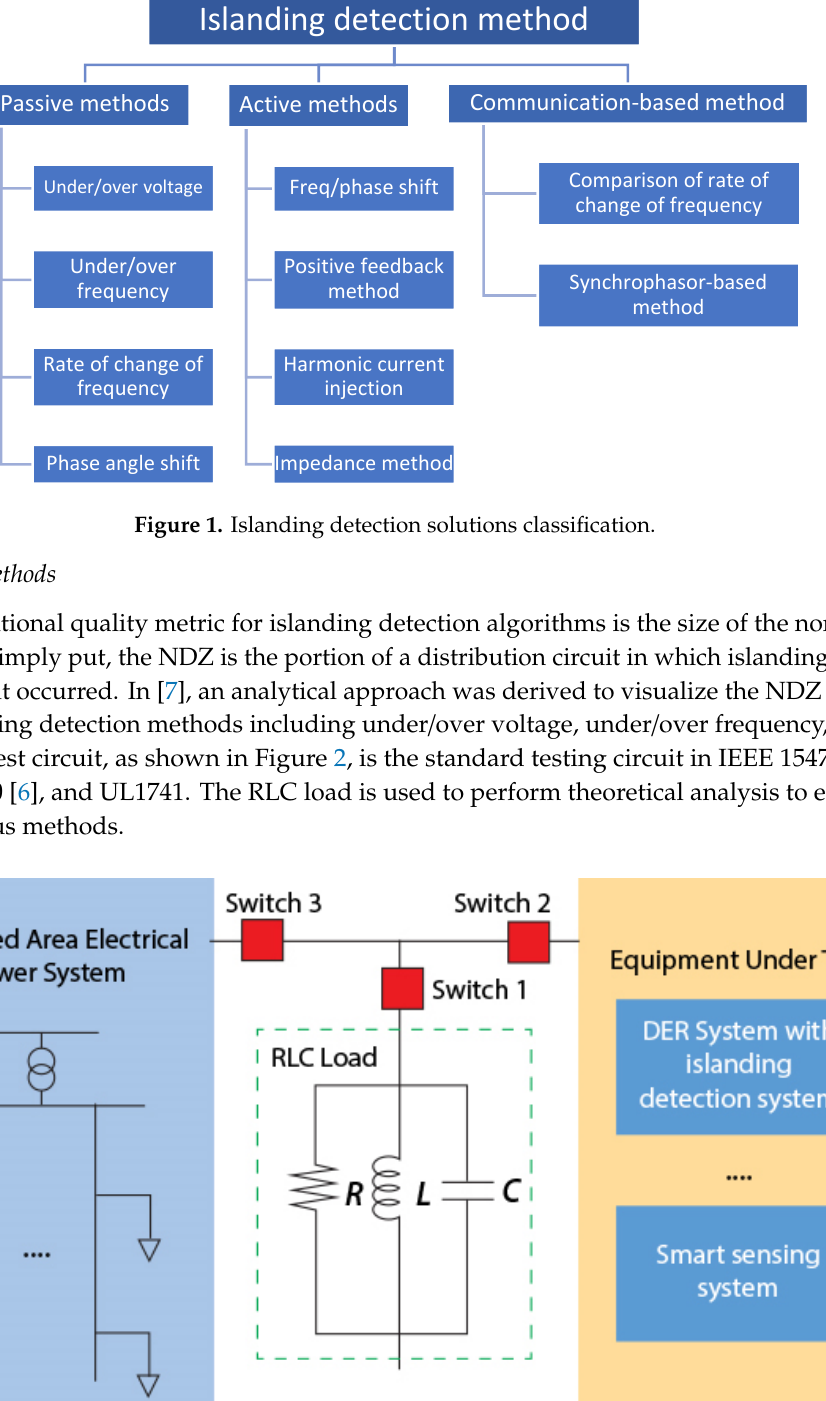
Figure 2. Unintentional islanding test configuration.